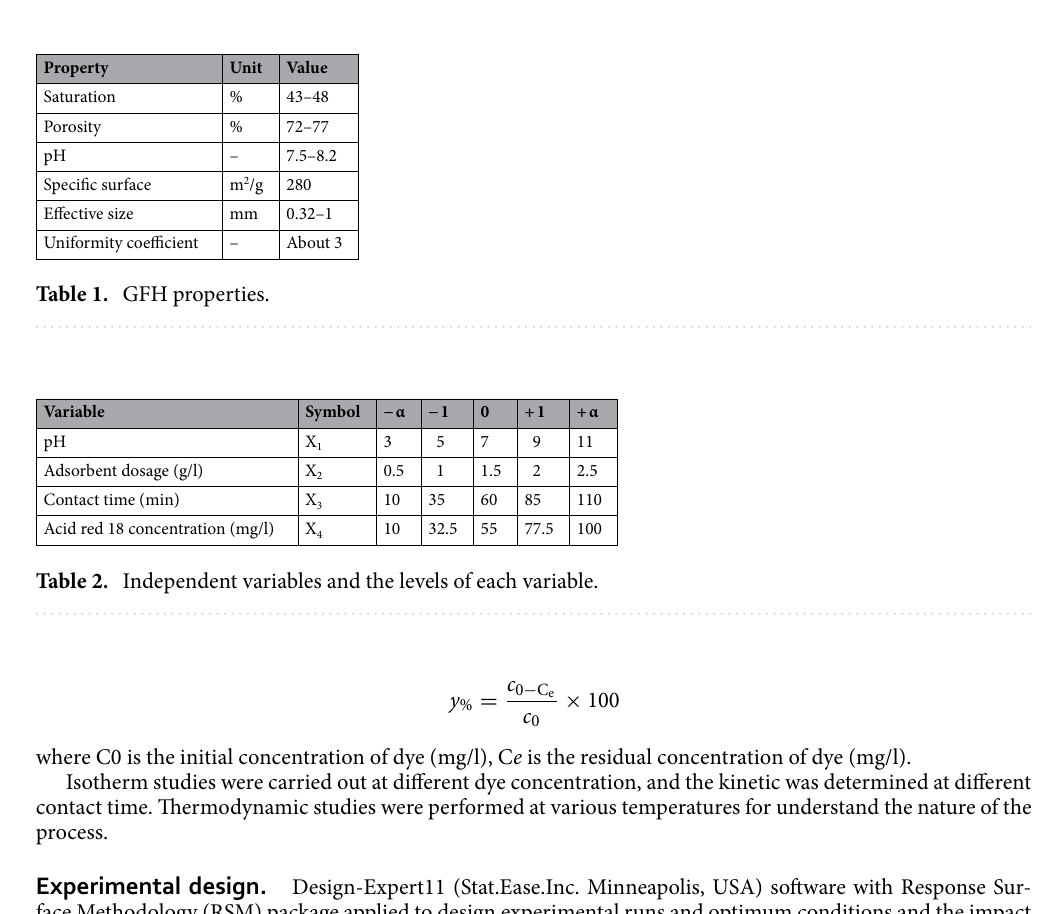
Figure 2. Acid red 18 molecular structure.